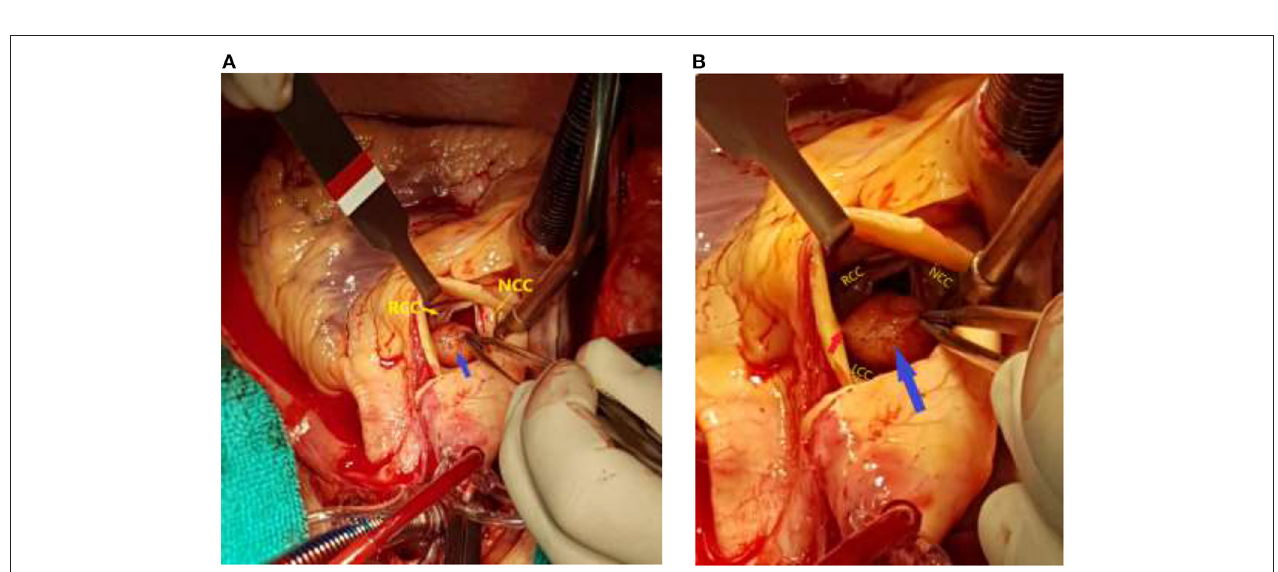
FIGURE 2 | Computed tomography of the chest: (A) A large fibroelastoma (red arrow) in the aortic bulb. (B) Cross-section showing localization of fibroelastoma (red arrow) right next to the left coronary artery ostium. (AoB) Aortic bulb. (LV) Left ventricle. (LCA) Left coronary artery. (RCA) right coronary artery.